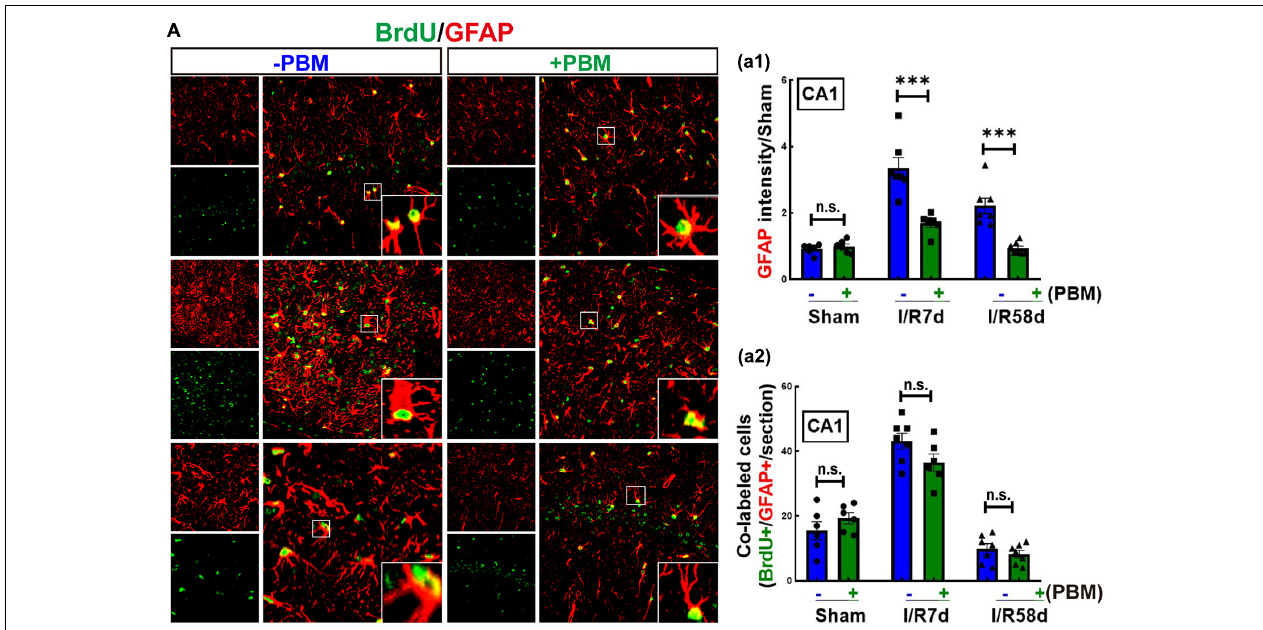
FIGURE 5 | Global cerebral ischemia enhances astrogliosis and reactive astrocytes 7 days after GCI reperfusion, and PBM suppresses astrocyte activation in both I/R 7 days and I/R 58 days animals. (A) Representative images of double IF staining for BrdU (green) and GFAP (red, an astrocyte marker). (a1) Quantification of GFAP fluorescence intensity (reflecting astrocyte activation), showing that PBM treatments attenuated reactive astrocytes compared to the I/R groups at the same timepoint in the hippocampal CA1 region. (a2) Quantification of the number of BrdU/GFAP colabeled cells (reflecting astrocytic regeneration/astrogliosis), showing that PBM had no significant effect on any of the indicated groups ( n = 6–7). ∗∗∗ P < 0.001. n.s., no significant difference. scale bar 50 µ m; magnification 40 ×